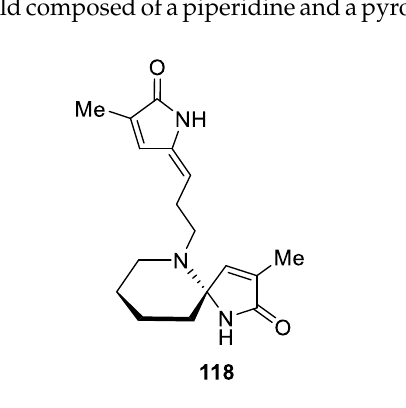
Figure 55. Alkaloid (±)-pandamarine isolated from Pandanus amaryllif olius.